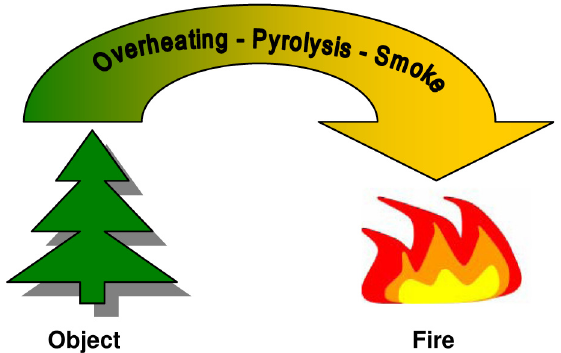
Figure 2. Generic fire formation diagram.